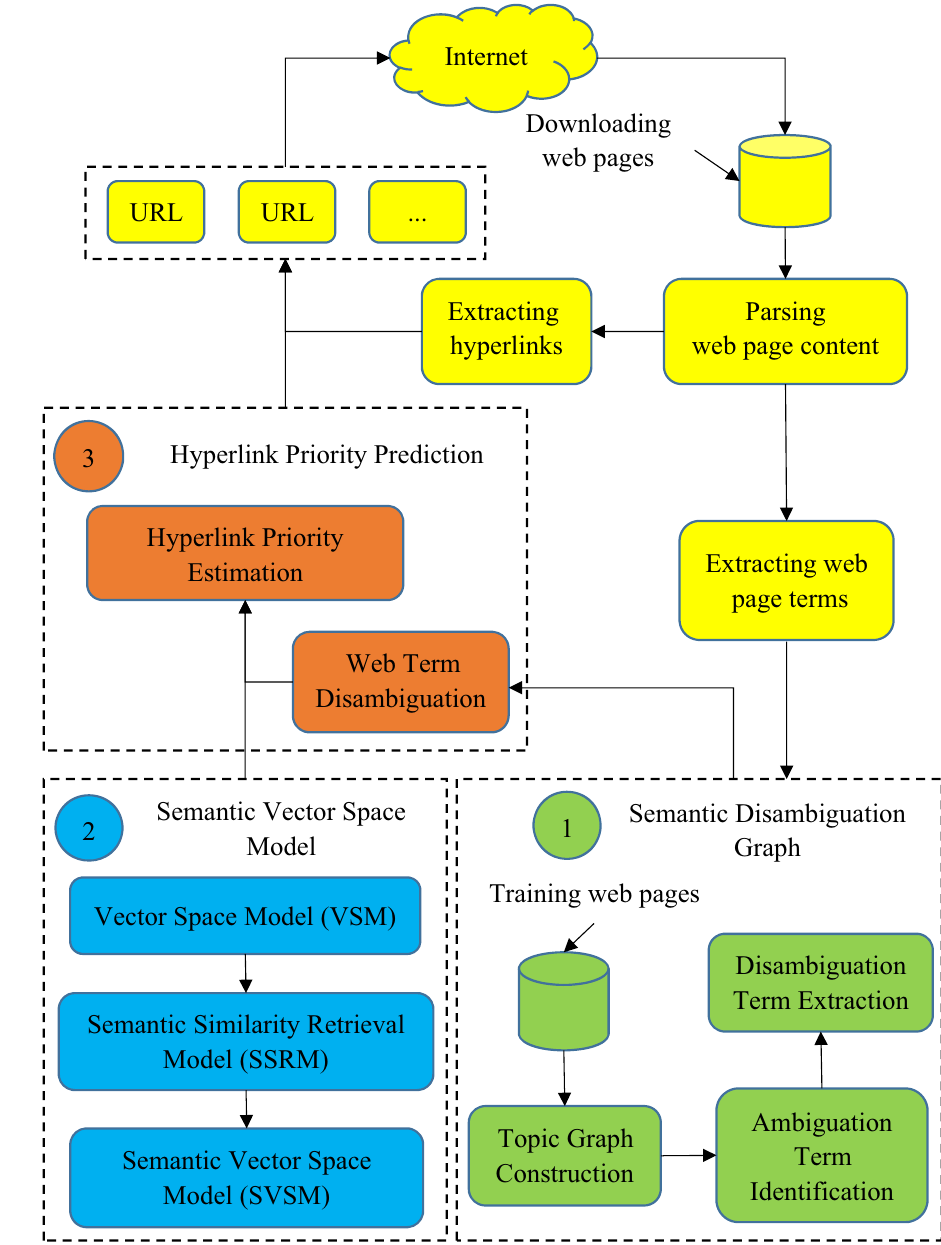
Fig. 1 The flowchart of the focused crawler based on